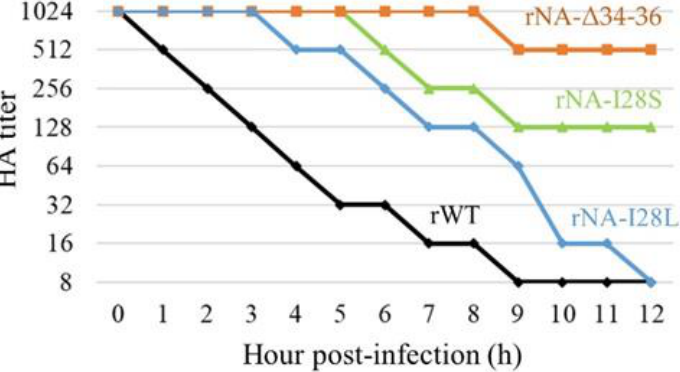
Figure 7. Elution of NA mutant viruses from erythrocytes. Two-fold dilutions of the NA transmembrane mutant rNA-I28S, rNA-I28L, or rNA- ∆ 3436 or rWT containing HA titers of 1:1024 were incubated with an equal volume of 0.7% turkey erythrocytes in microplate wells at 4 ◦ C for 1 h. The plates were then stored at 37 ◦ C, and the reduction in HA titers was evaluated periodically for 12 h.